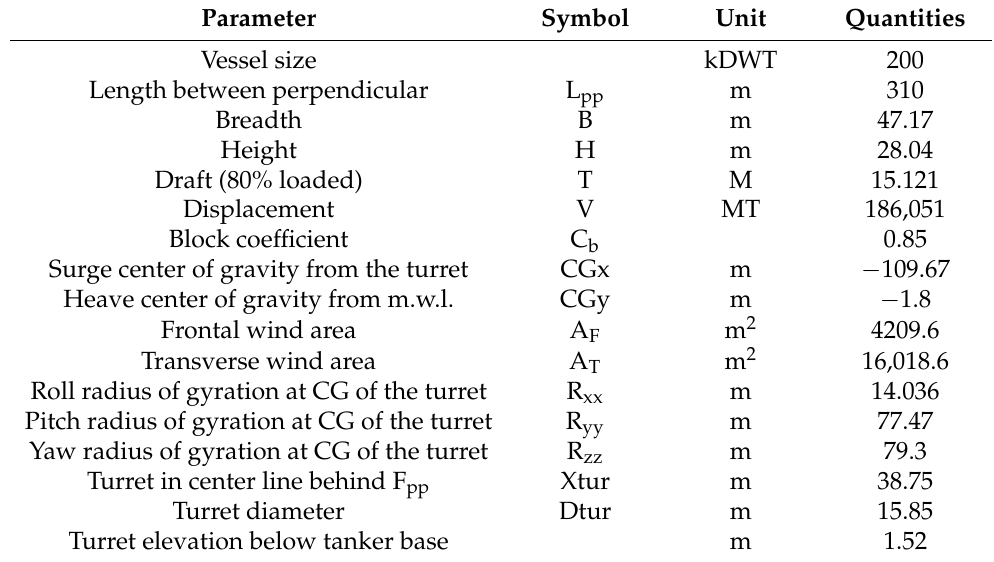
Table 1. FPSO main design